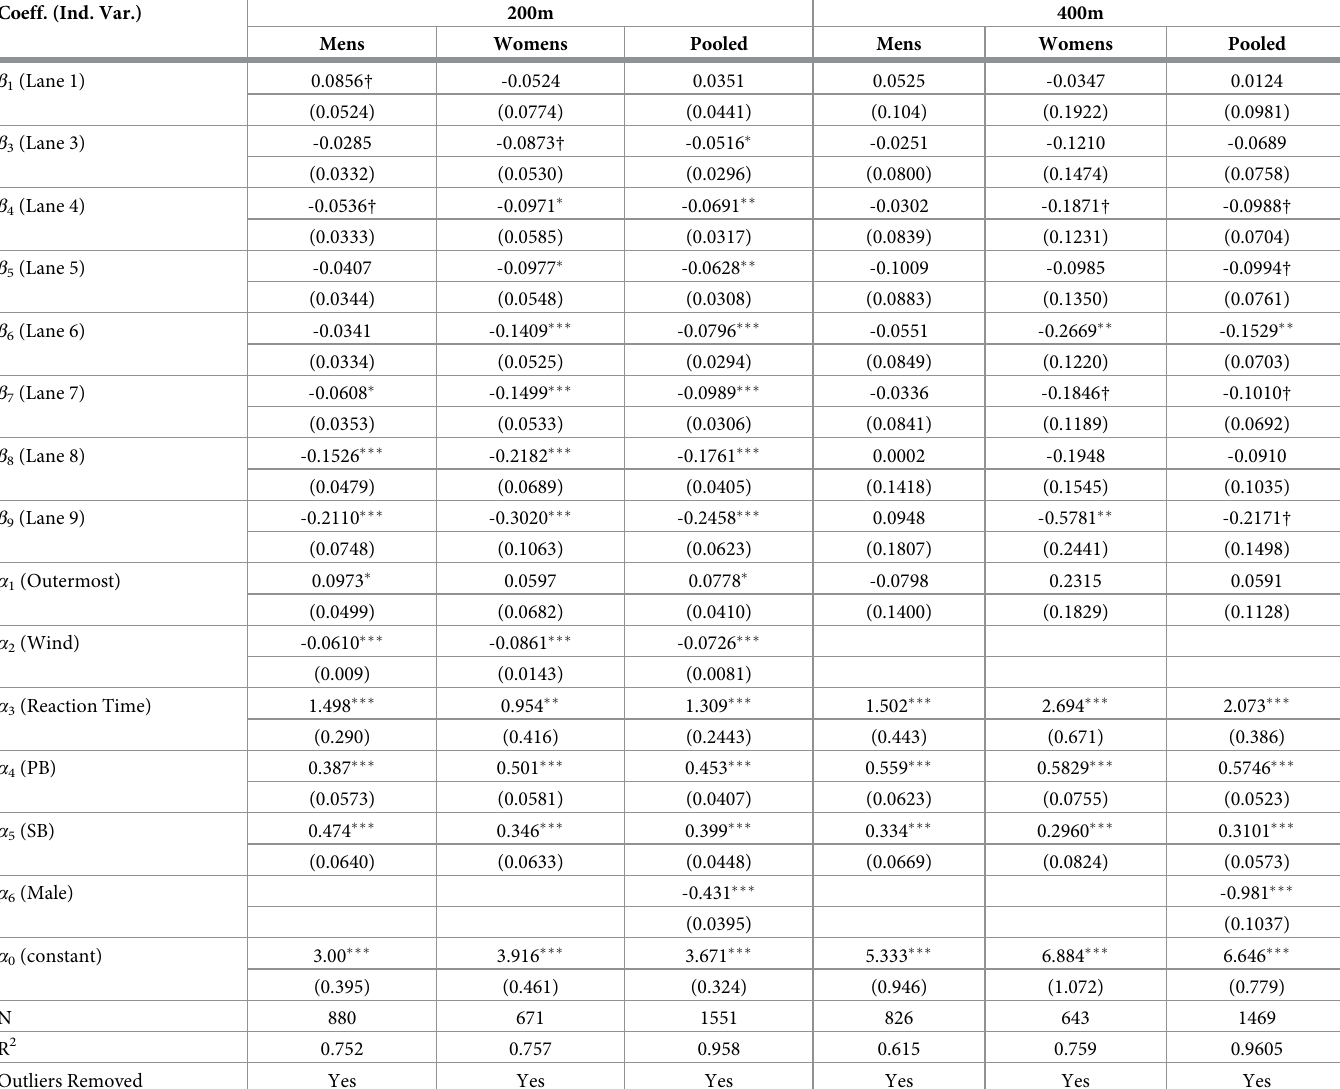
Table 6. Regression results for 200m and 400m with a separate indicator variable for the outermost lane. Coeff. (Ind.